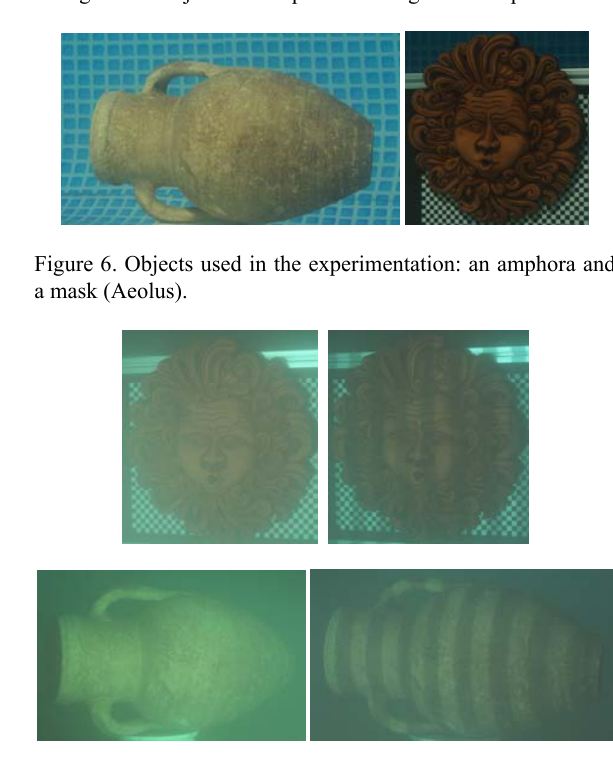
Figure 5. Projection of a pattern during active acquisition.